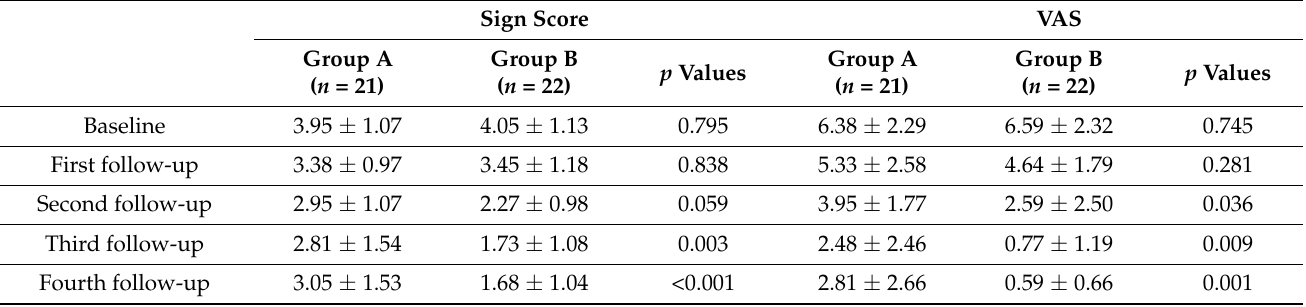
Table 2. Clinical response (sign score) and symptom score (VAS) at follow-up assessment by treat- ment (mITT).